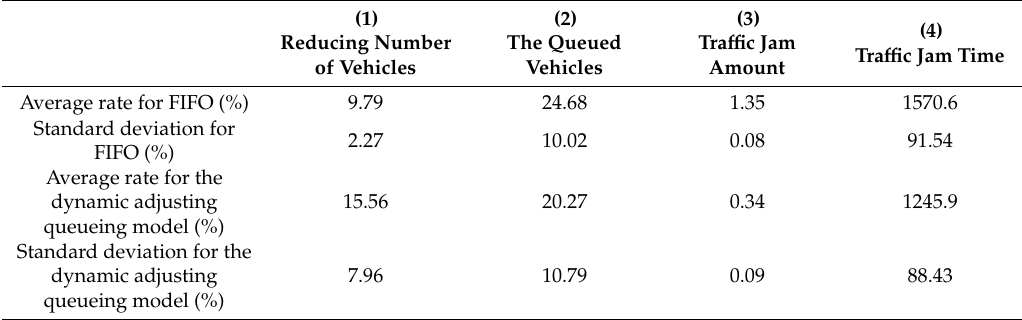
Table 3. Statistics regarding Monte Carlo